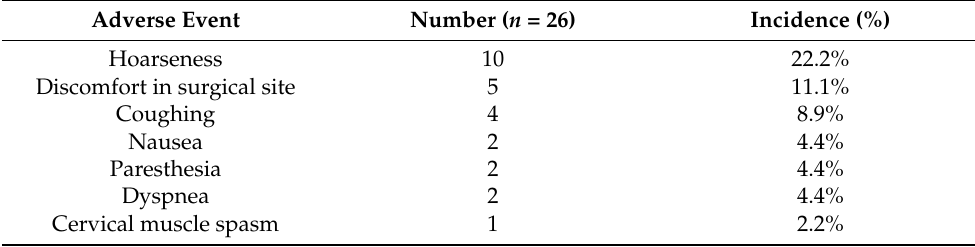
Table 6. Postoperative adverse events.